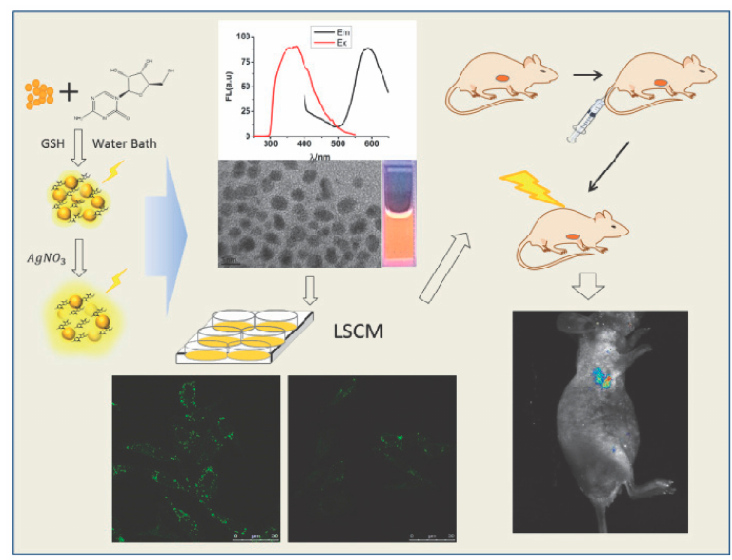
Figure 18. Scheme illustration of the process for cytidine mediated gold-silver nanoclusters (AuAg NCs) (Copyright Ref [193], WILEY publications).